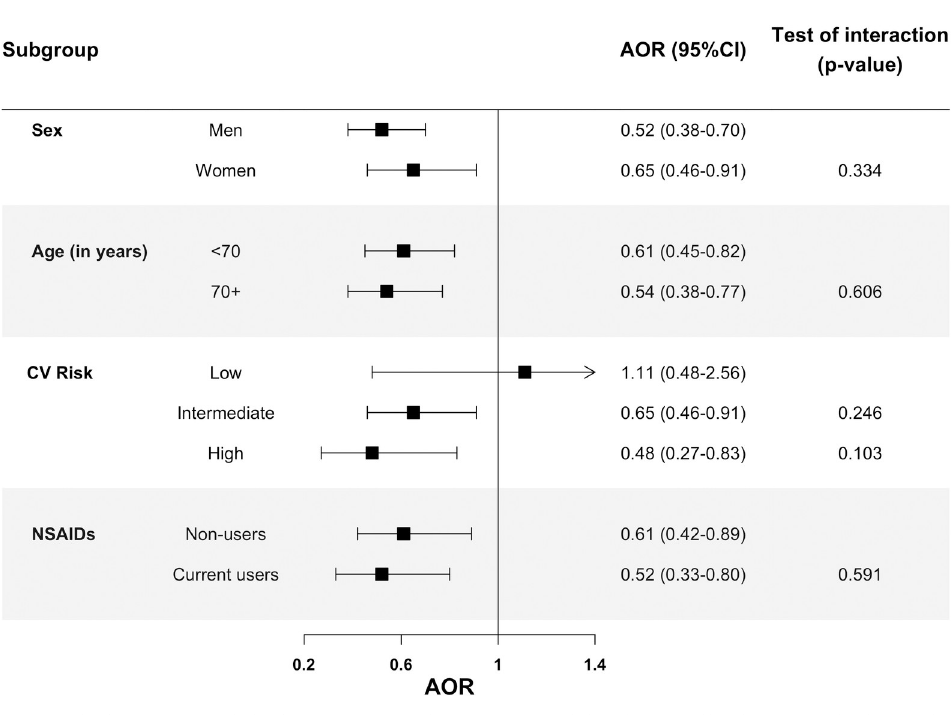
Fig 2. Risk of acute myocardial infarction associated to current use of chondroitin sulfate by sex, age, background Cardiovascular (CV) risk and concomitant use of NSAIDs. Abbreviations: AOR: Adjusted Odds Ratio, CI: Confidence Interval; CV: Cardiovascular; NSAIDs: Non-steroidal Anti-inflammatory Drugs.